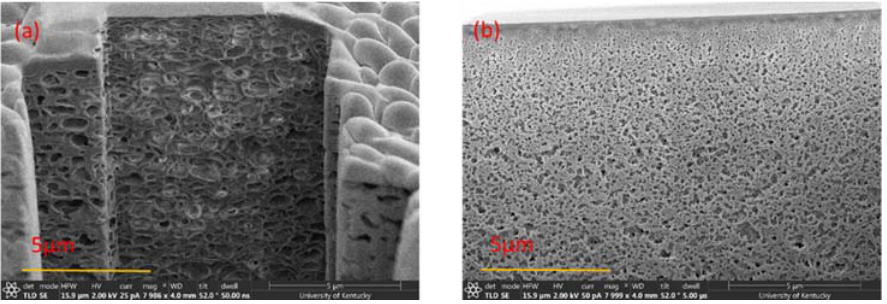
Figure 10. Cross-sectional FIB-SEM images of PSf/PolarClean ultrafiltration membranes: ( a ) After BSA filtration; ( b ) After DI water backwash.